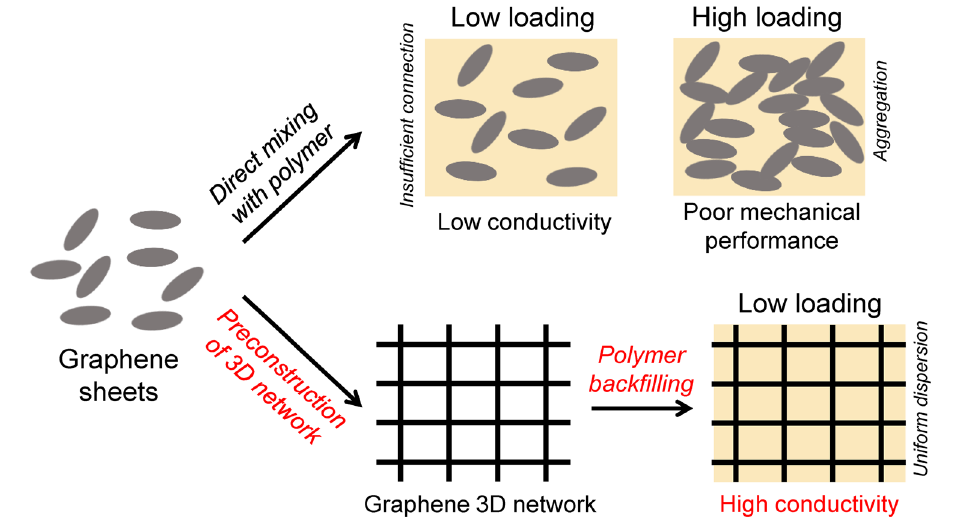
Fig. 6 Schematic illustrating the graphene dispersion in polymer composites fabricated by different compounding